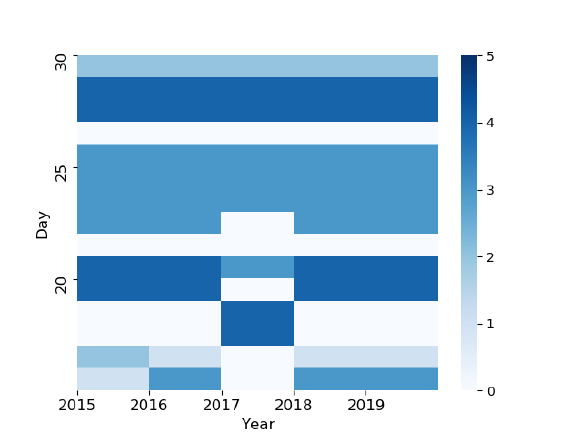
Figure 5: Clustering output for NO 2 for last 15 days in Q 1 over 2015 to 2019.